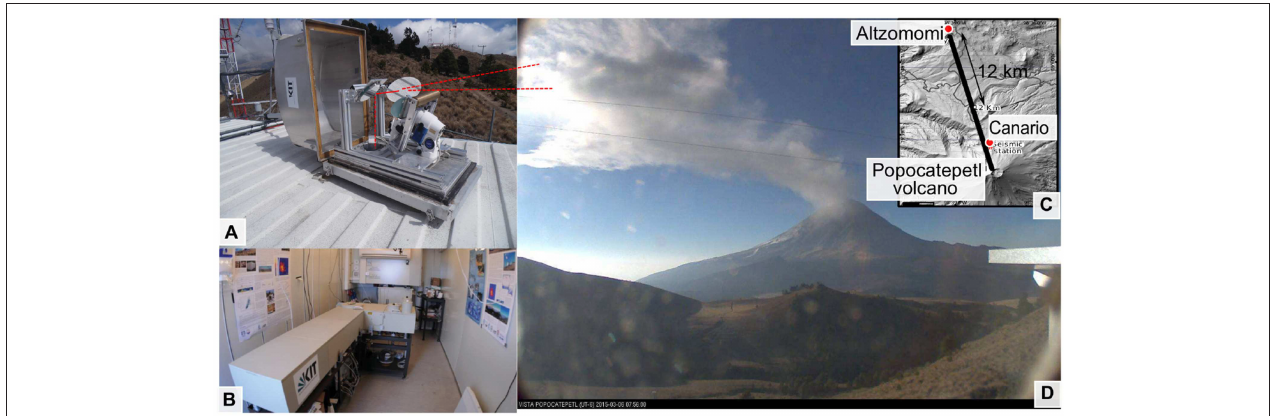
FIGURE 1 | Presentation of the measurement site: The NDACC Altzomoni Atmospheric Observatory (A) Automated solar tracker installed on the roof of the station. (B) Picture of the high resolution FTIR spectrometer inside the container. (C) Location of the Altzomoni observatory, the seismic Canario station, and the Popocatépetl volcano. (D) A typical geometry for solar occultation measurements of the volcanic